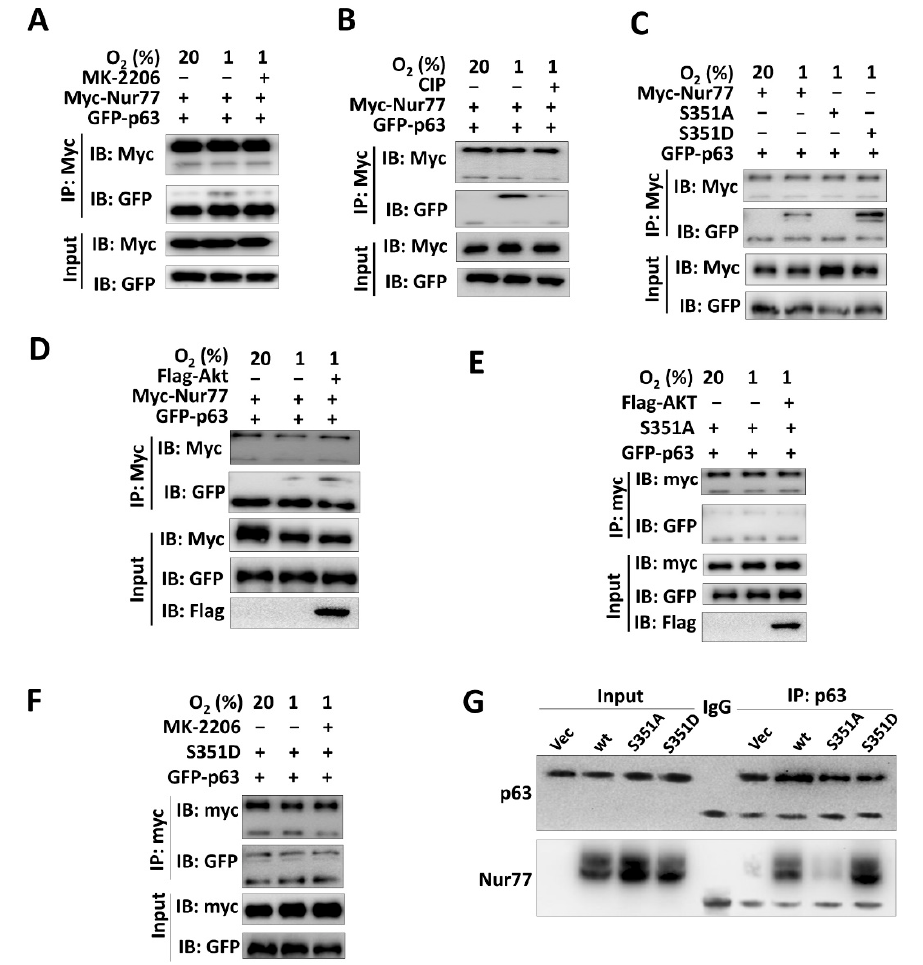
Figure 4. Akt-mediated phosphorylation regulates Nur77 interaction with p63. HEK-293T cells carried by different expression vectors were used. ( A , B ) The cells were cultured under normoxia (20%) or hypoxia (1%). Hypoxic cells were treated with or without 1 µ M MK-2206 for 4 h ( A ). The lysates collected from untreated cells under hypoxia were incubated with or without CIP (0.2 U/mL) at 37 ◦ C for 60 min ( B ). ( C ) Mutations were introduced into the Nur77 phosphorylation site of S351. ( D , E ) The overexpression of Akt modulated the interaction between Nur77 (or mutant) and p63. ( F ) The interaction of Nur77/S351D (untunable phosphorylation form) with p63 was analyzed in HEK-293T cells following the administration of vehicle or 1 µ M MK-2206 (Akt inhibitor). ( G ) The metastatic tissues were collected from a tail-vein metastatic model, as indicated in Figure 3E. ( C – G ) the capability of Nur77 or its mutants to interact with p63 was evaluated with Co-IP assays. Molecular weights for proteins are indicated in the full, uncropped, annotated Western blot images (Figure